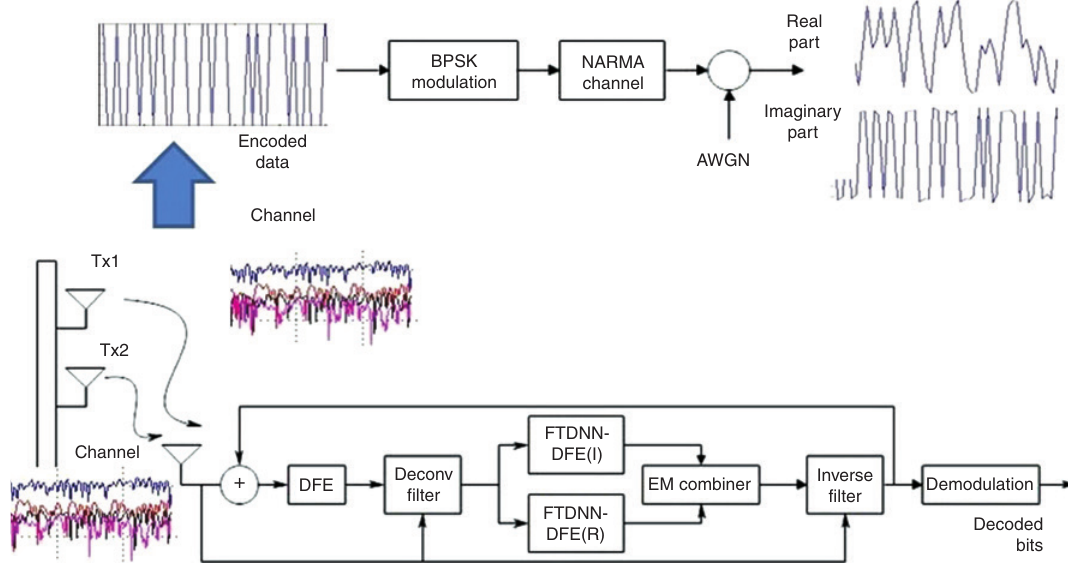
Figure 5: Proposed Split FTDNN-DFE Channel Estimator.